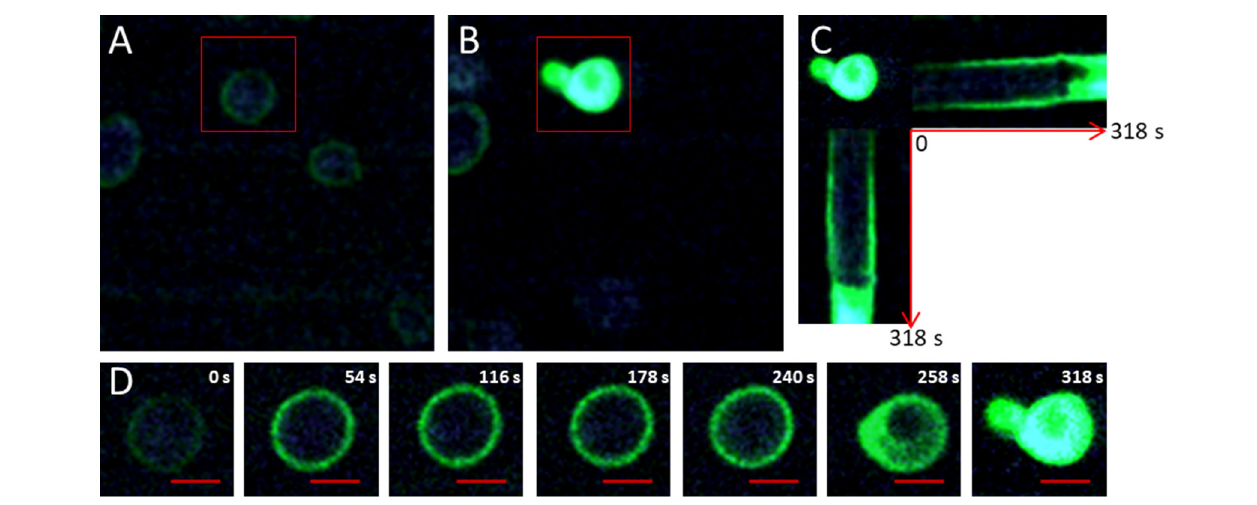
FIGURE 1 | Visualization of 1 O 2 production using SOSG. (A) Photography of the initial photo-oxidation treatment induced by the production of 1 O 2 and labeled by SOSG (6 mg/L) in Saccharomyces cerevisiae cells acquired by fluorescence and two-photon microscopy at 830nm for a light power of 400 W/cm ² . The red rectangle indicates the targeted cell exposed to light stimulation phases of 1.5.10 4 W/cm 2 . (B) Photograph of the end of the photo-oxidation treatment at t = 318s . (C) Horizontal and vertical sections of the temporal evolution of fluorescence in targeted cells during the photo-oxidation treatment. (D) Crop on the targeted cell exposed to a light power of 1.5.10 4 W/cm 2 at 830nm. The red bar represents 2 µ m.